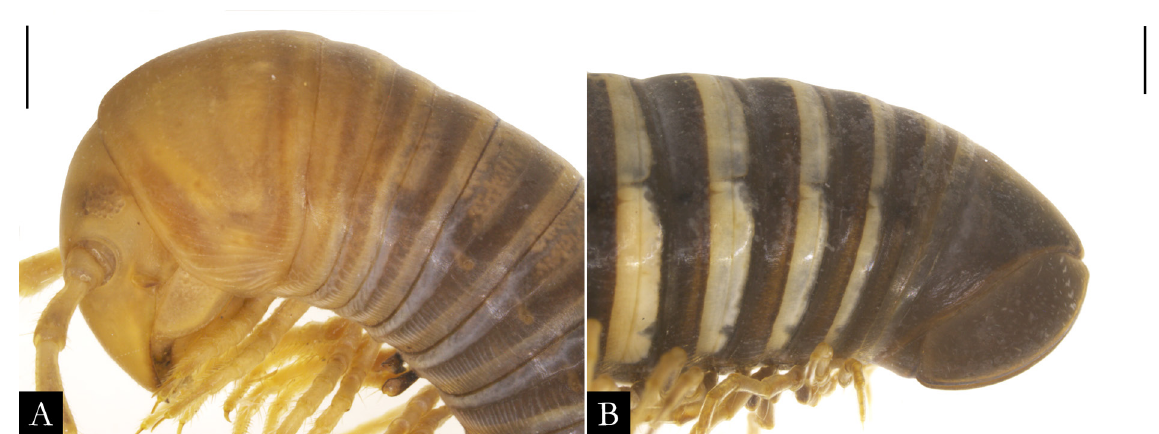
Fig. 129. Pseudonannolene strinatii Mauriès, 1974, ♀ (IBSP 7635), in lateral view. A . Anterior region. B . Posterior region. Scale bars = 1